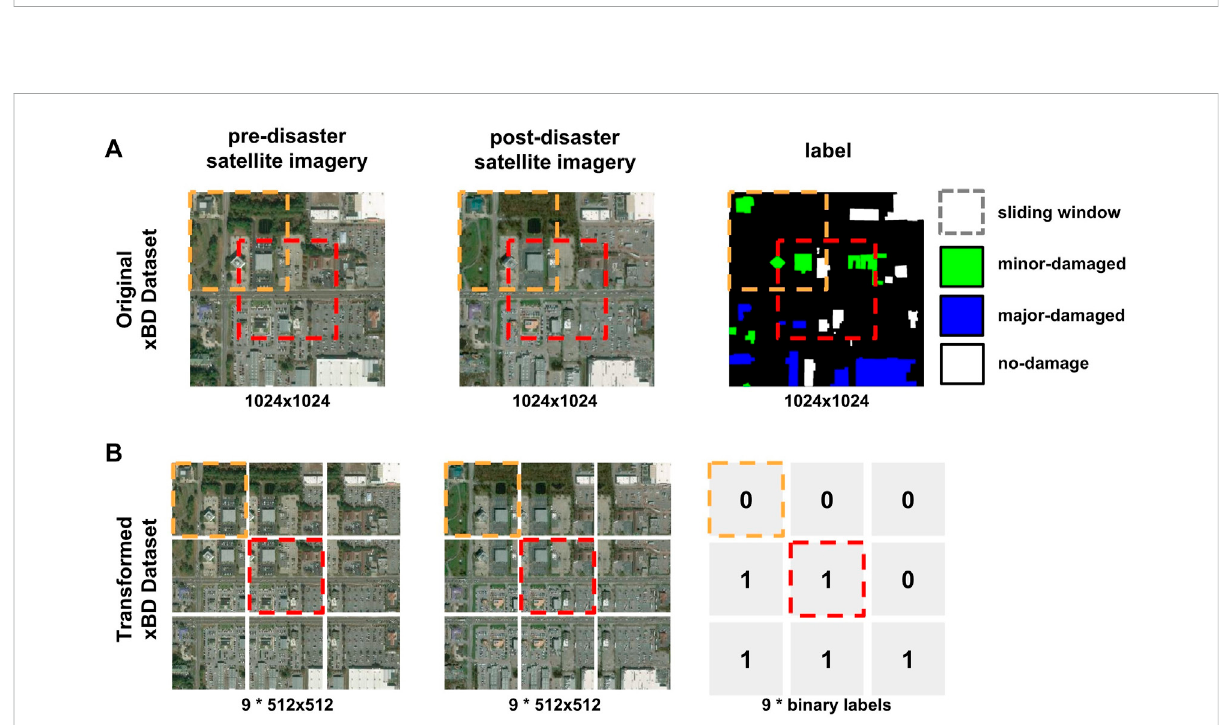
FIGURE 3 Method for simplifying the initial xBD dataset. The sliding window method crops each data sample (A) into nine different samples in (B) . The window size is 512×512, and the sliding unit is 256. Since the windows are half-overlapped, there are three windows on each side, resulting in 3×3windows.Theorangeandredboxesshowexamplesofourwindows. (A) showsthesatelliteimageryintheoriginalxBDdatasetbeforeandaftera disasteratzoomlevel16,with1024×1024pixels.Thelabelhas fi veclasses:nobuilding(black),nodamage(white),minordamage(green),major damage (blue), and destroyed (red). (B) shows the result after cropping. Each image tile is now in zoom level of 17 with 512×512 pixels. Finally, to matchtheinputsizeoftheResNet-18encoder,weresizedeachimageto224×224pixels.Thecroppedimageislabeled1ifitincludespixelsofmajor damage or destruction; otherwise, it is labeled